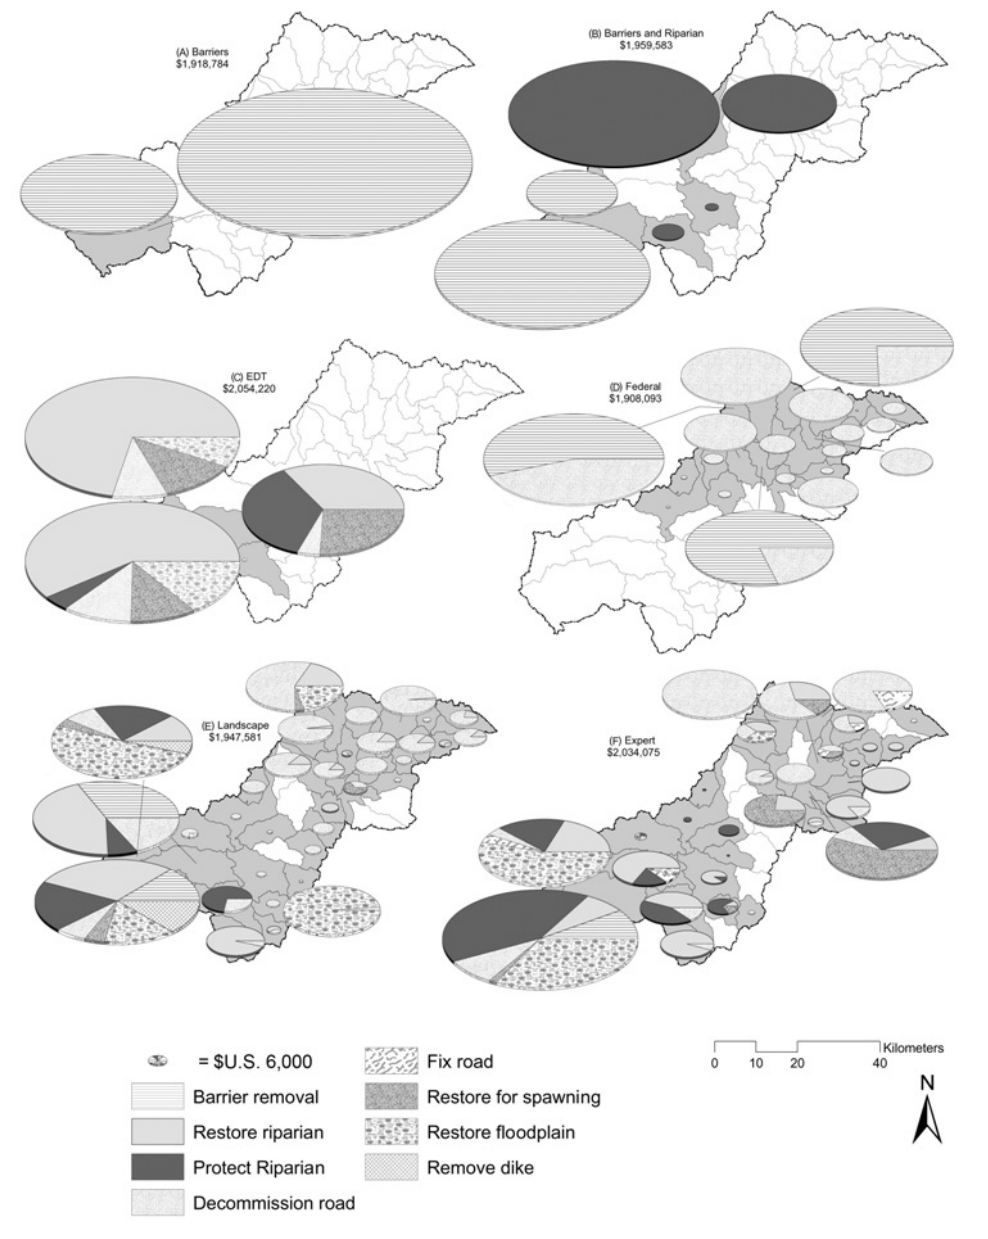
Fig. 3. Figures 3A–F describe the spatial allocation of funds for each of the six watershed management strategies. The size of the pie represents the total funds allocated/subwatershed. The slices of pie describe how funds were allocated among possible restoration and protection activities. A $U.S. 6000 pie is shown in the legend for scale. Proposed budgets for the landscape and expert strategies were averaged for display